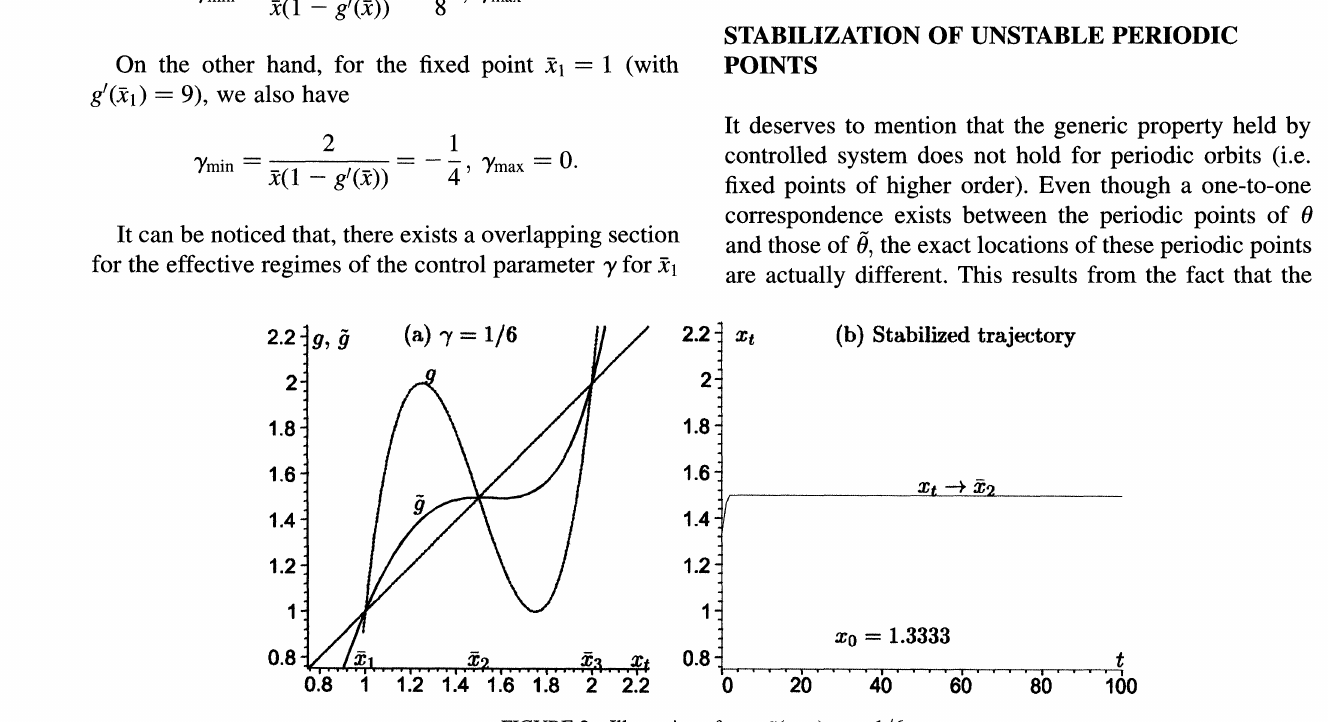
FIGURE 2 Illustration of xt (xt-), "y